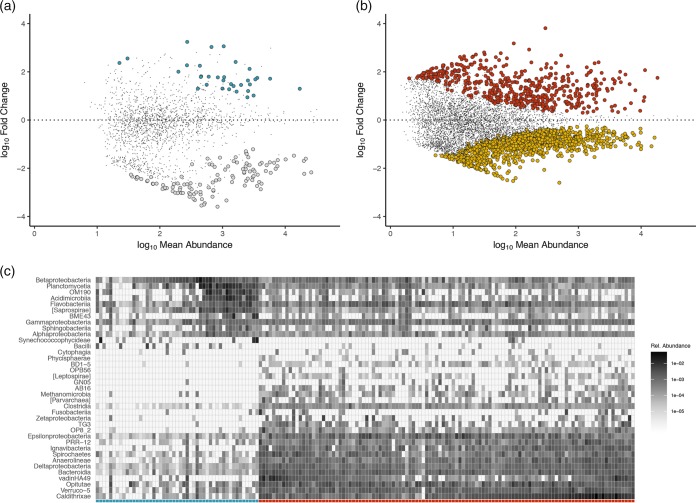
Host compartments are enriched and depleted for certain OTUs. (a) Enrichment and depletion of OTUs detected on leaves compared with those from the seawater environment as determined by differential abundance analysis. Each point represents an individual OTU, and the position along the y axis represents the abundance fold change relative to the primary source environment. Colors are the same as in Fig. 1; significantly enriched and depleted OTUs are blue and silver, respectively. (b) Results of differential abundance analysis for OTUs detected on roots compared with those from the sediment environment. Significantly enriched and depleted OTUs are red and gold, respectively. (c) Heatmap showing the taxonomic compositions of enriched taxa, aggregated at the class level, on leaves and roots. Darker shades of gray correspond to higher mean relative abundances of OTUs in each taxonomic class. Leaf and root samples are differentiated on the x axis by blue and red markers, respectively. White tiles indicate taxa that were not detected in particular samples. Matrix seriation (the process of rearranging matrix rows and columns for visual interpretation) was accomplished using a principal component analysis.